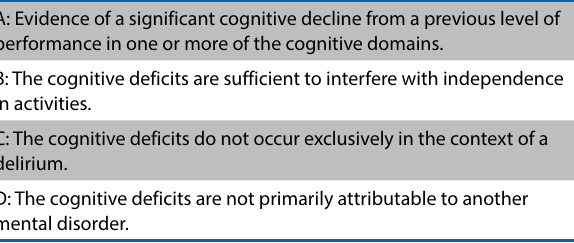
Table 4: The DSM V criteria for major neurocognitive